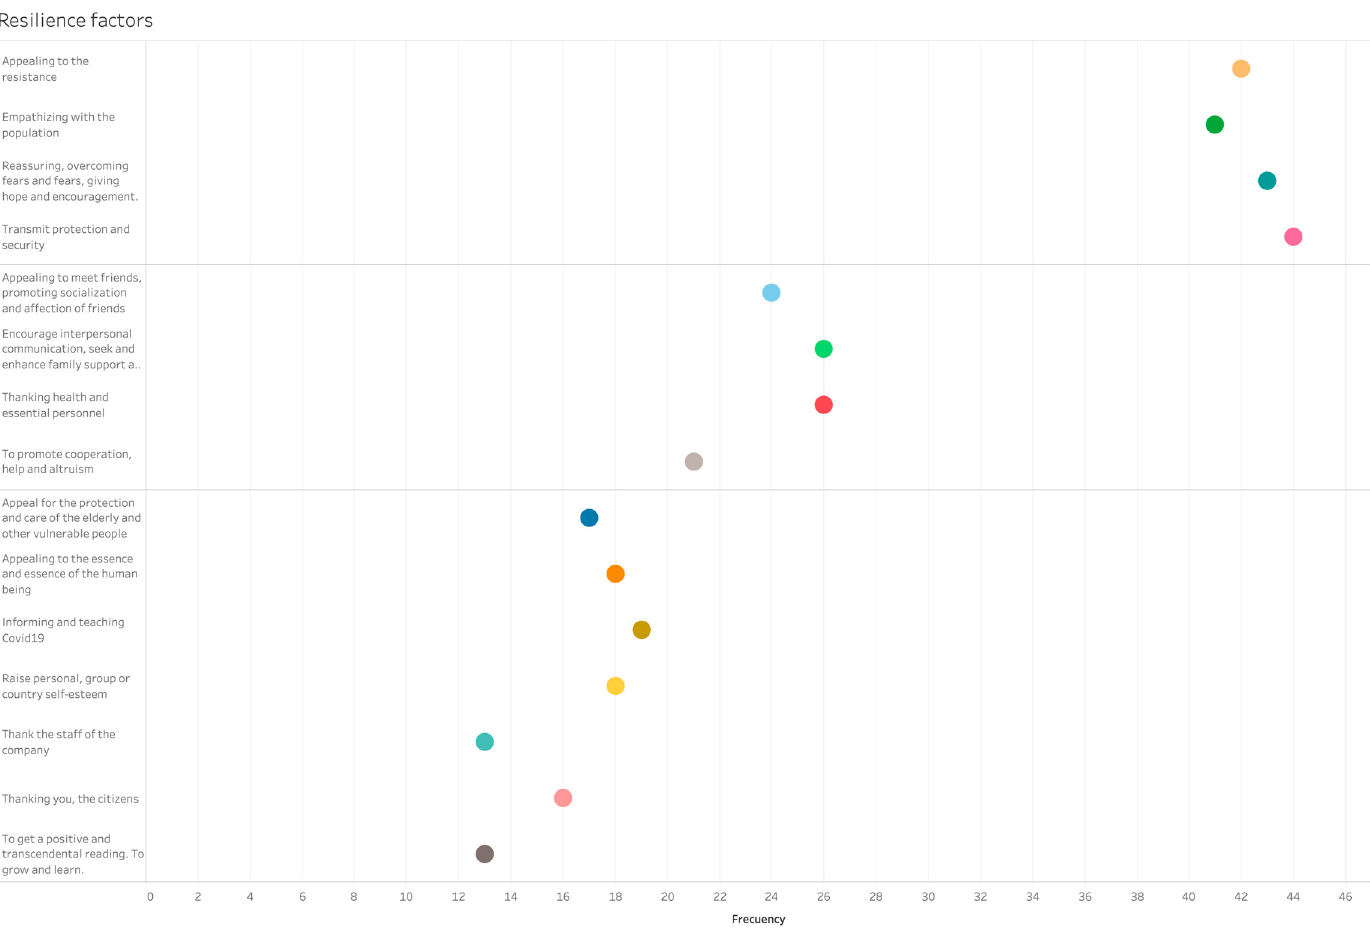
Figure 10. Groups of resilience factors in advertising spots.